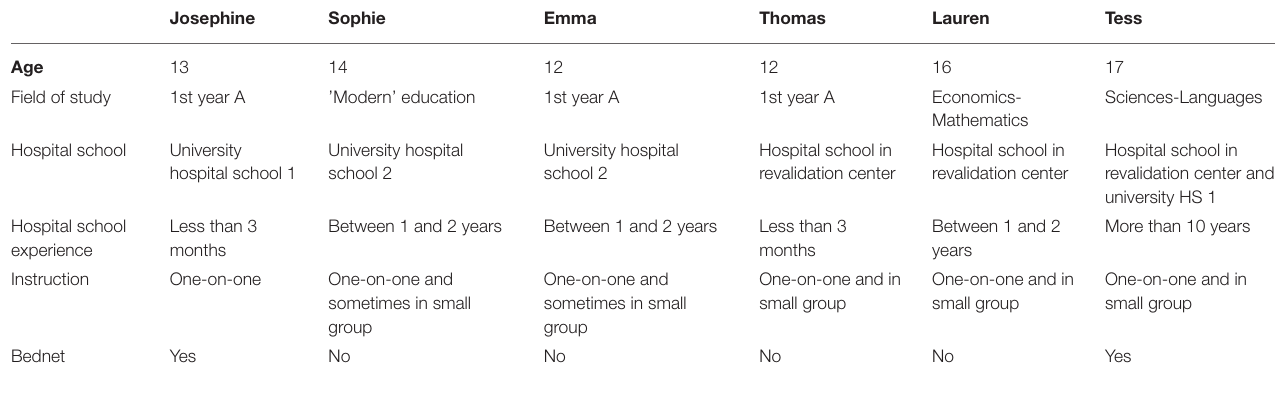
TABLE 1 | Overview of respondent